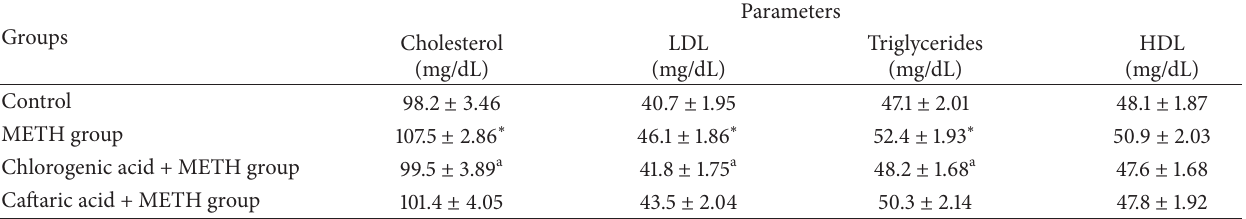
Table 3: Effect of chlorogenic and caftaric acids on lipid fractions of METH-injected